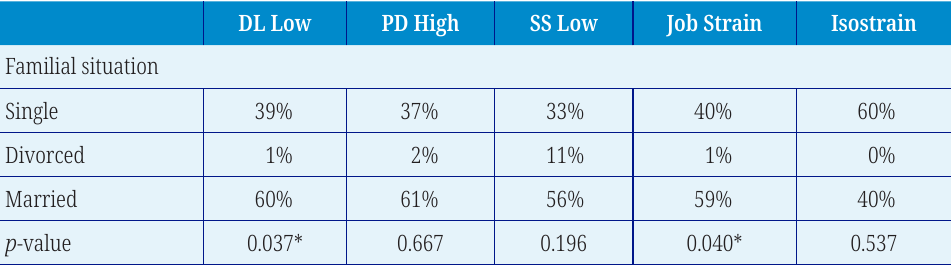
Table 5. Distribution of studied population according to number of